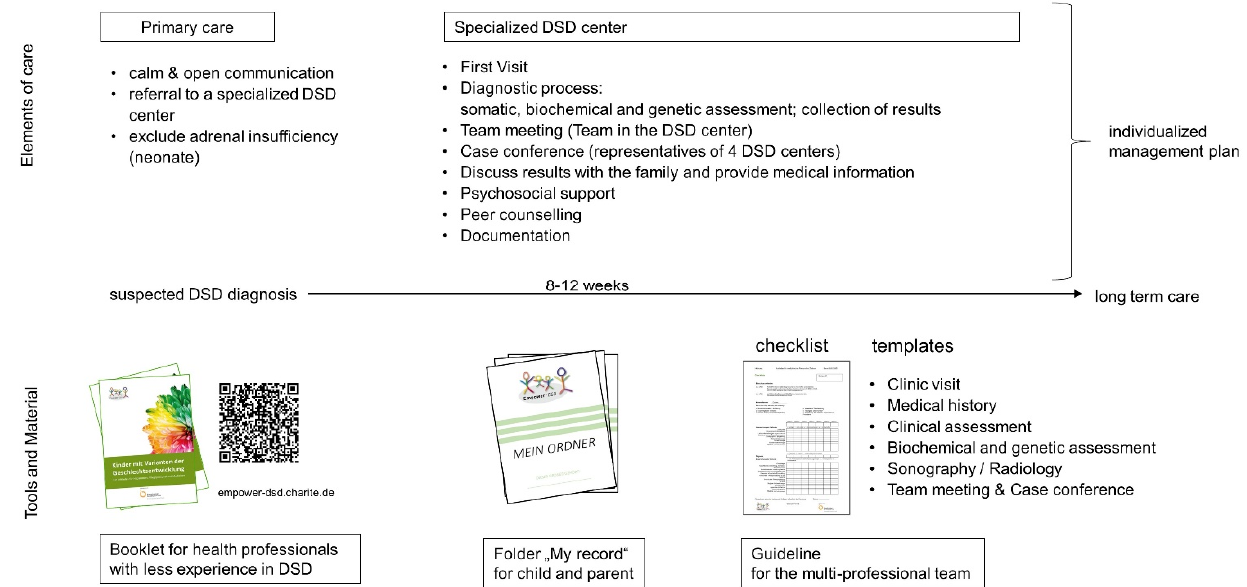
Figure 1. Elements of care and developed tools of the information management.